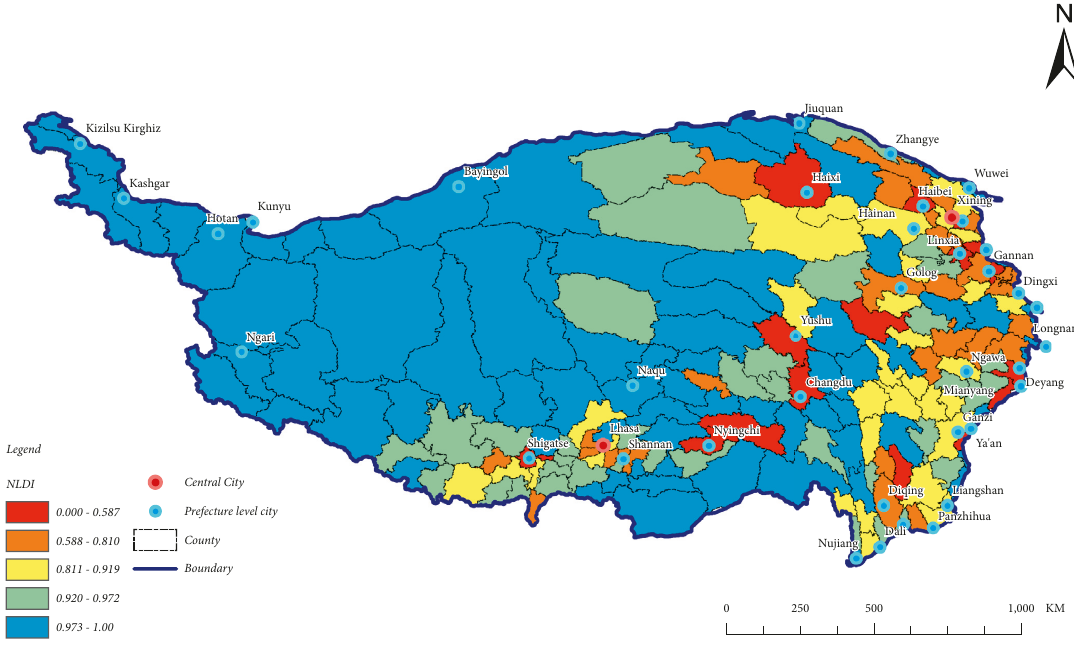
The overall level of TIID in the Qinghai–Tibet Plateau is relatively low. The TIID between counties is different, showing a trend of sparseness from east to west, from central cities to remote areas. Among them, areas of very high level are Golmud City in the middle and the urban agglomeration areas in the east with Xining as the